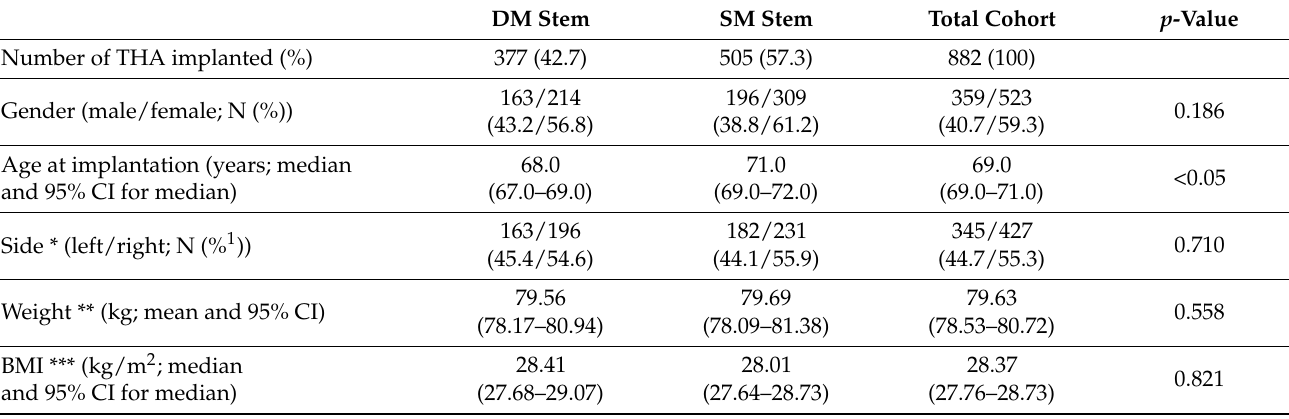
Table 1. Demographic data of the